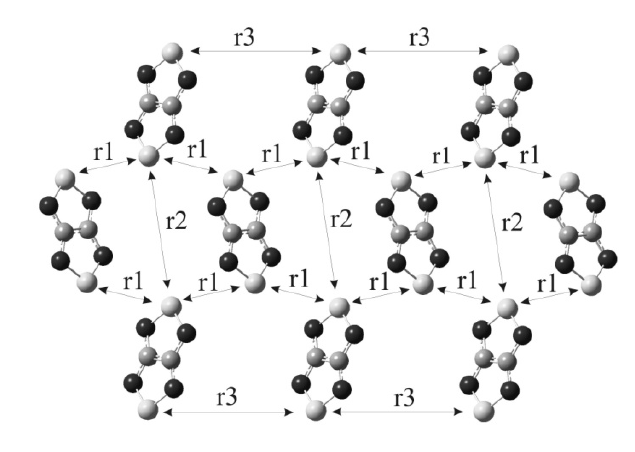
Figure 20. The layer of RAs of 22 in the XRD structure of salt 74 ([CoCp r1-r3—the shortest distances between the S atoms of RAs in the unique